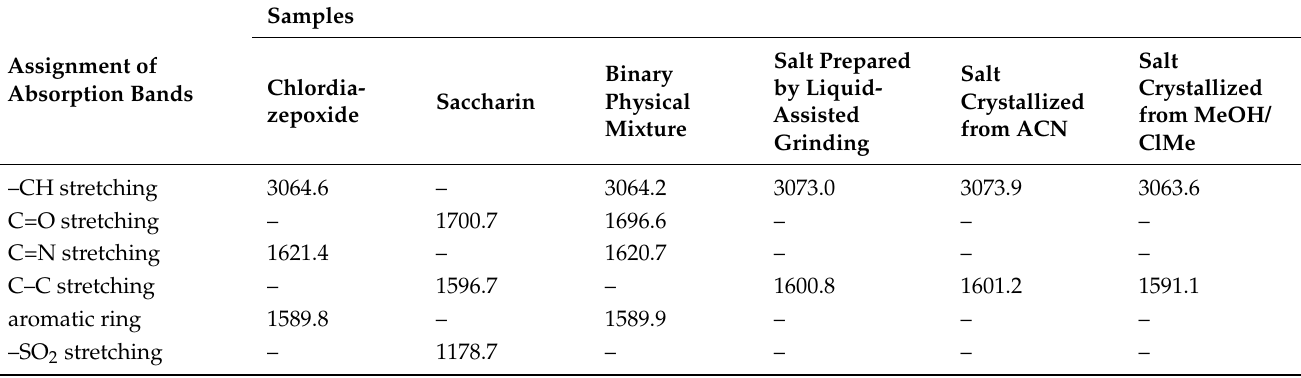
Table 8. Water solubility of chlordiazepoxide, saccharin, and saccharin salts of